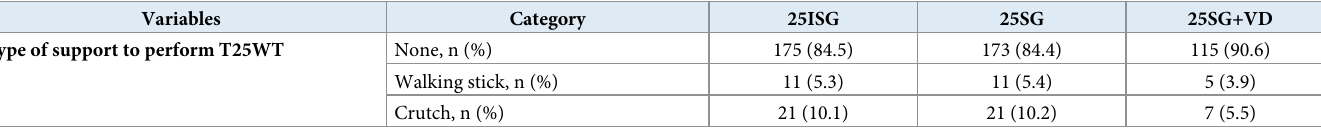
fect agreement between both the devices.